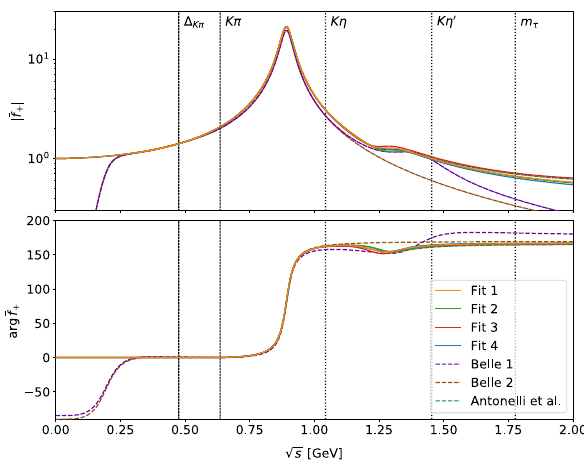
Fig. 7 Vector form factor ¯ f + (top: modulus, bottom: phase) with the parameters of the fit results of Table